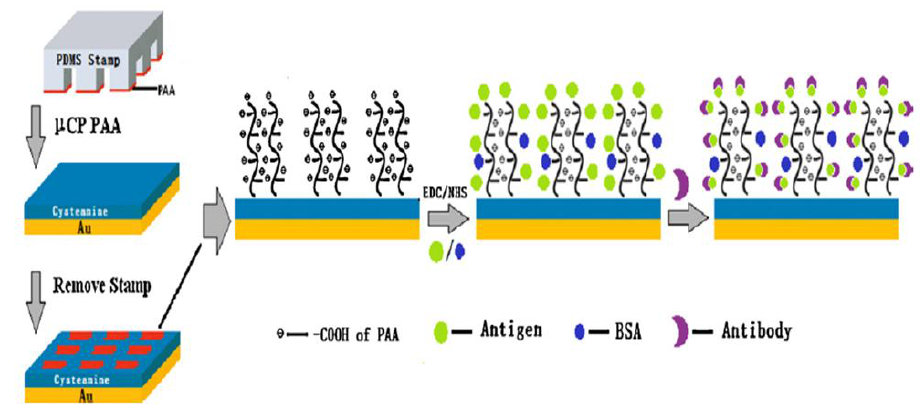
Figure 11. Schematic diagram of patterning Poly(acrylic acid) (PAA) brushes and immunoassay along SPRi process. Reprinted with permission from Applied Surface